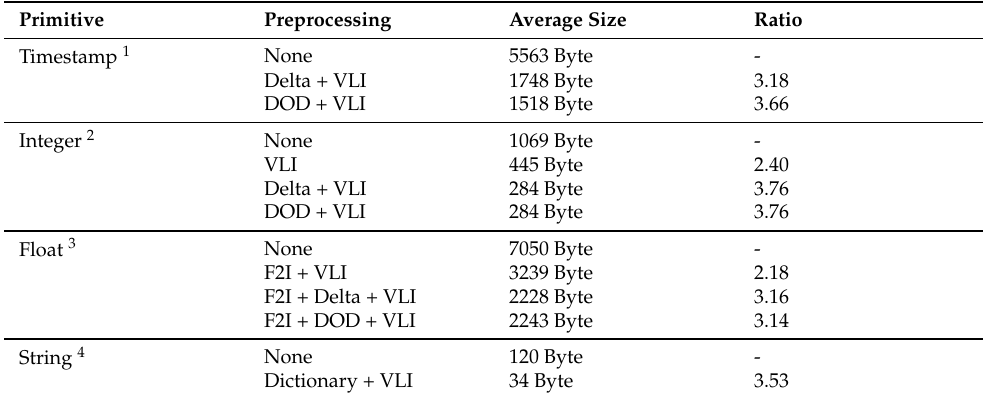
Table 3. Performance of the preprocessing methods.